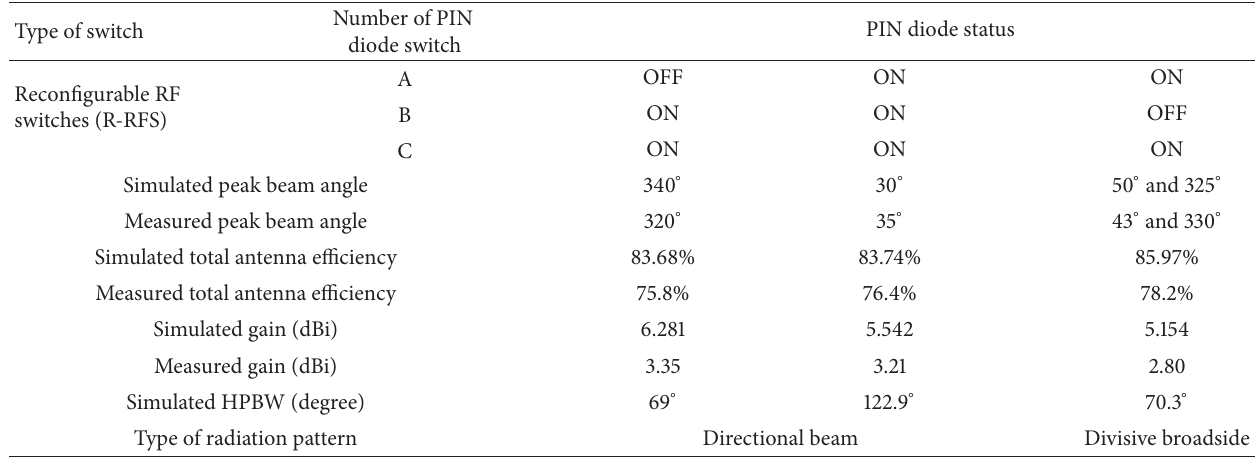
Table 1: PIN diode switches configuration of the measured and simulated